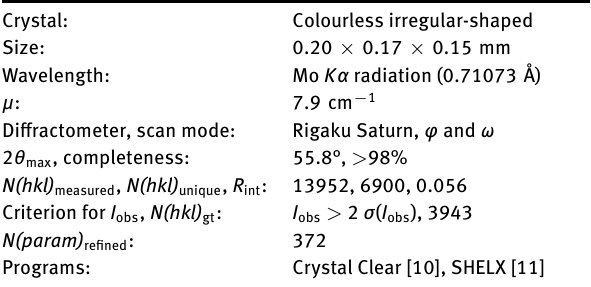
Table 1: Data collection and